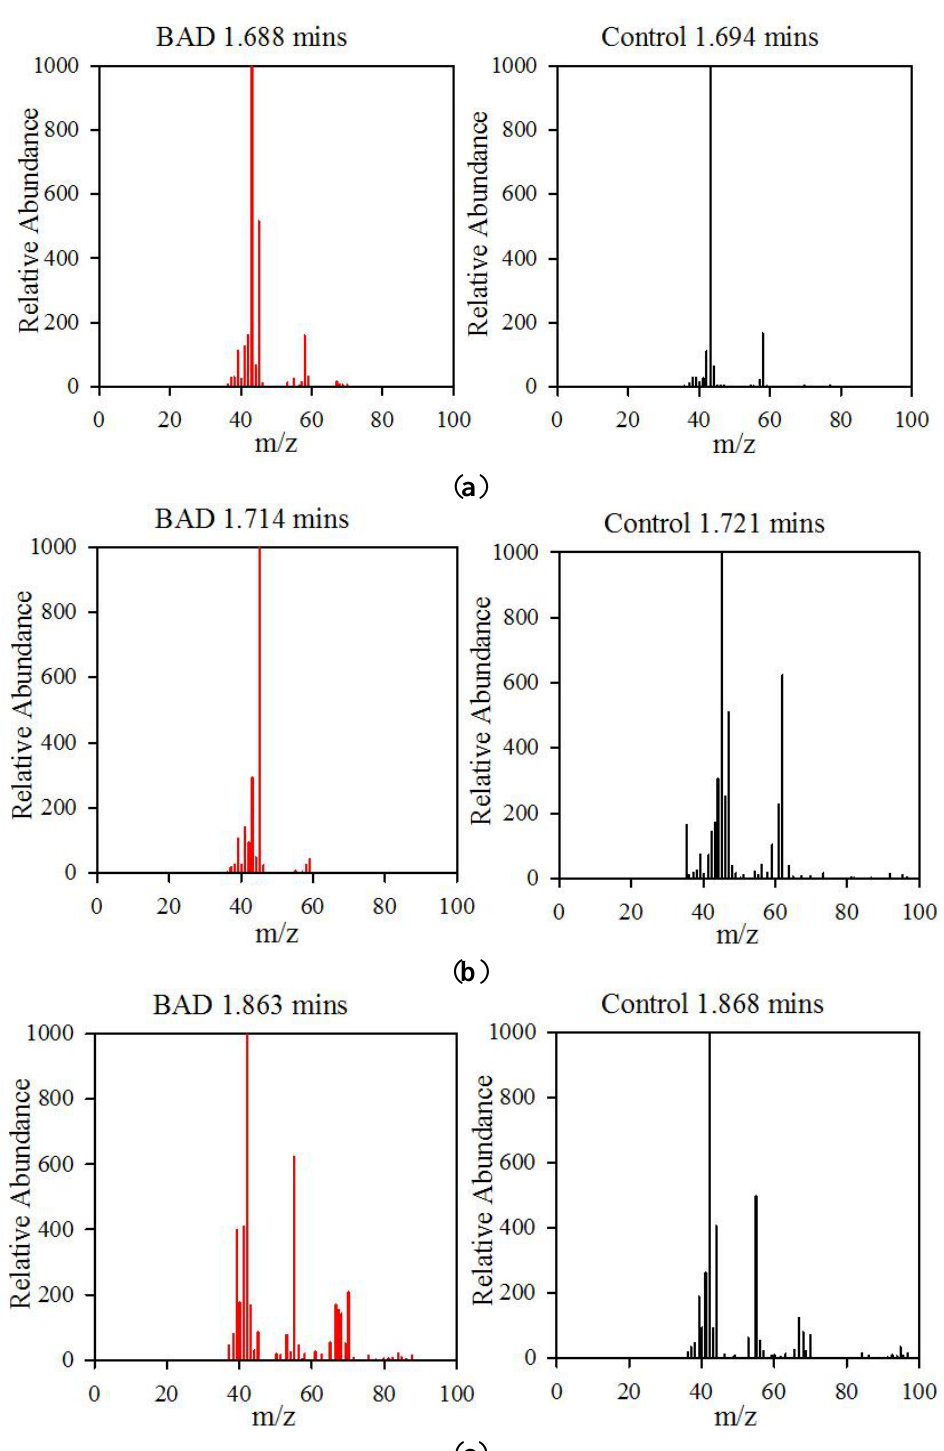
Figure 6. Comparison of BAD and Control Mass Spectra at similar Retention